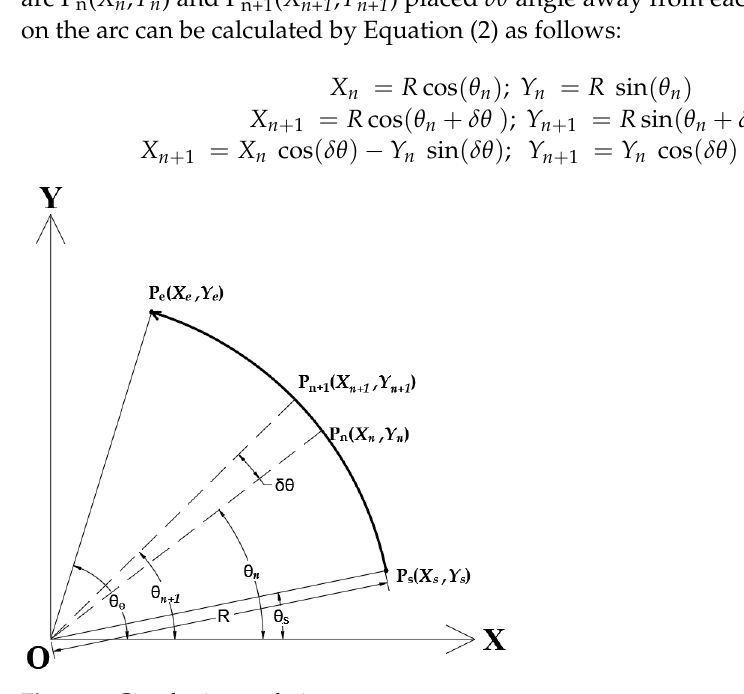
Figure 9. Circular interpolation.